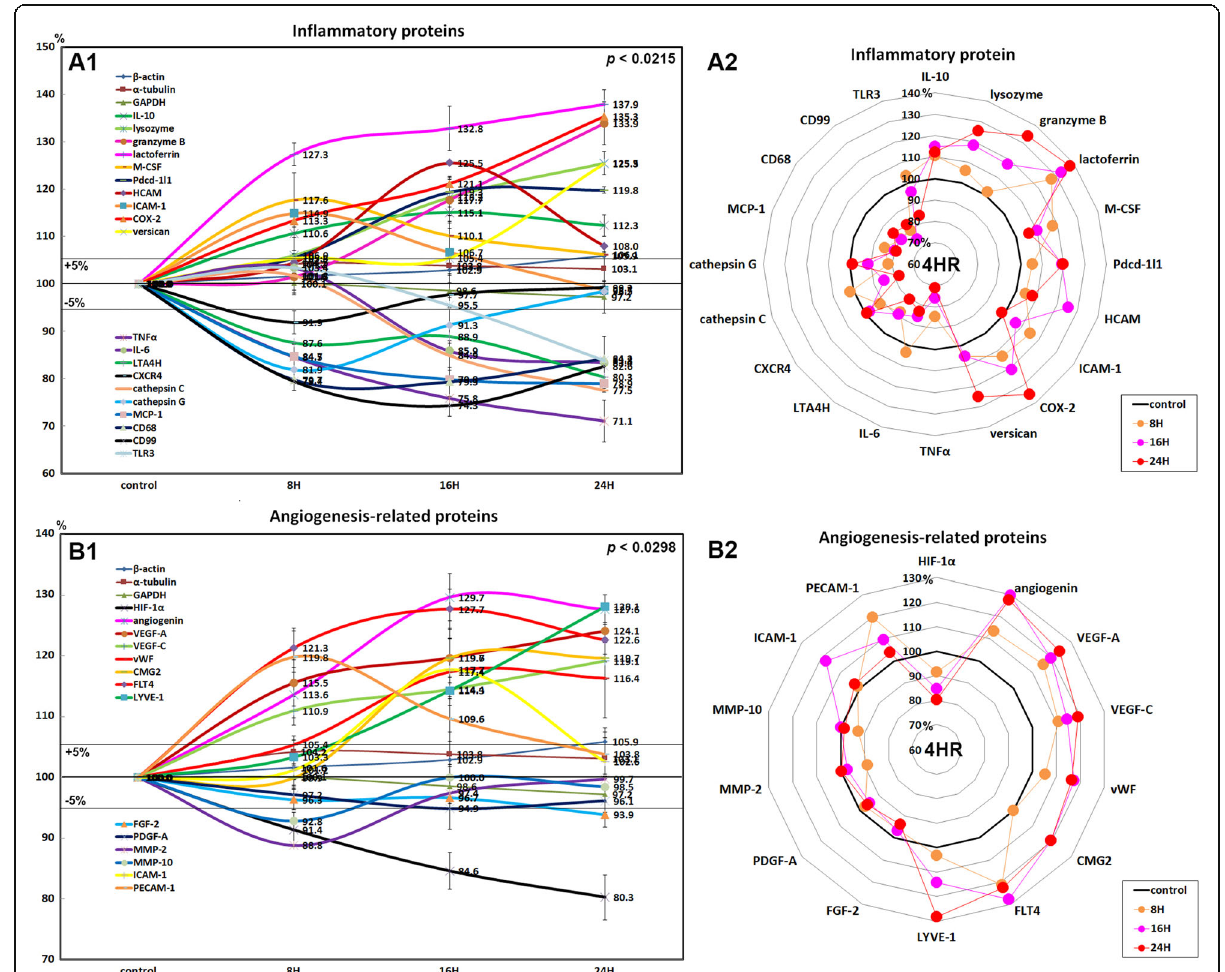
Fig. 3 Expressions of inflammatory proteins ( A1 , A2 ) and angiogenesis-related proteins ( B1 , B2 ) in 4HR-treated HUVECs as determined by IP- HPLC. The line graphs ( A1 , B1 ) show protein expression patterns on the same scale (%) versus culture time (8, 16, or 24 h), whereas the star plots ( A2 , B2 ) showed the differential expression levels of proteins in a circular manner after 8, 16, or 24 h of treatment on appropriate scales